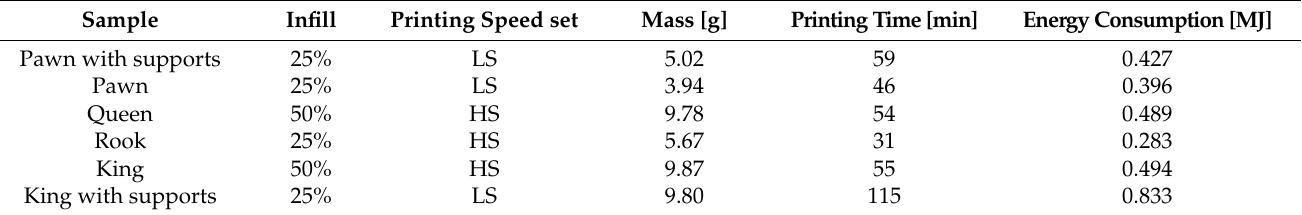
Table 7. Characterization of weight, printing time and energy consumption for the 3D printed chess